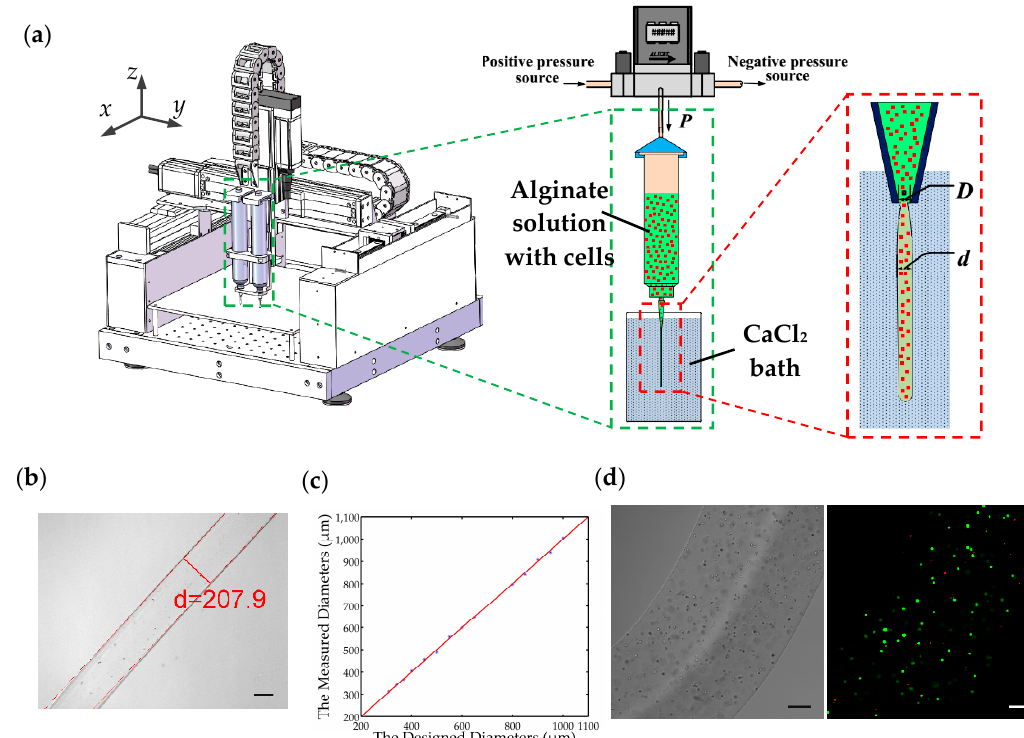
Figure 1. ( a ) Schematic diagram of the pneumatic micro-extrusion system: P indicates the driving pressure, D indicates the inner diameter of the nozzle, and d is the diameter of the hydrogel fiber; ( b ) calcium alginate fiber generated using a 0.2 mm nozzle with a driving pressure of 2.0 PSI, and its diameter measurement. The scale bar is 100 μ m; ( c ) the comparison of the designed and measured diameters of 15 hydrogel fibers. The red line is the 45° line that represents a unitary mapping between the designed and measured diameters in the ideal case; ( d ) porcine fetal muscle fibroblast cell-laden calcium alginate fiber and the corresponding fluorescent image. The scale bar is 100 μ m.